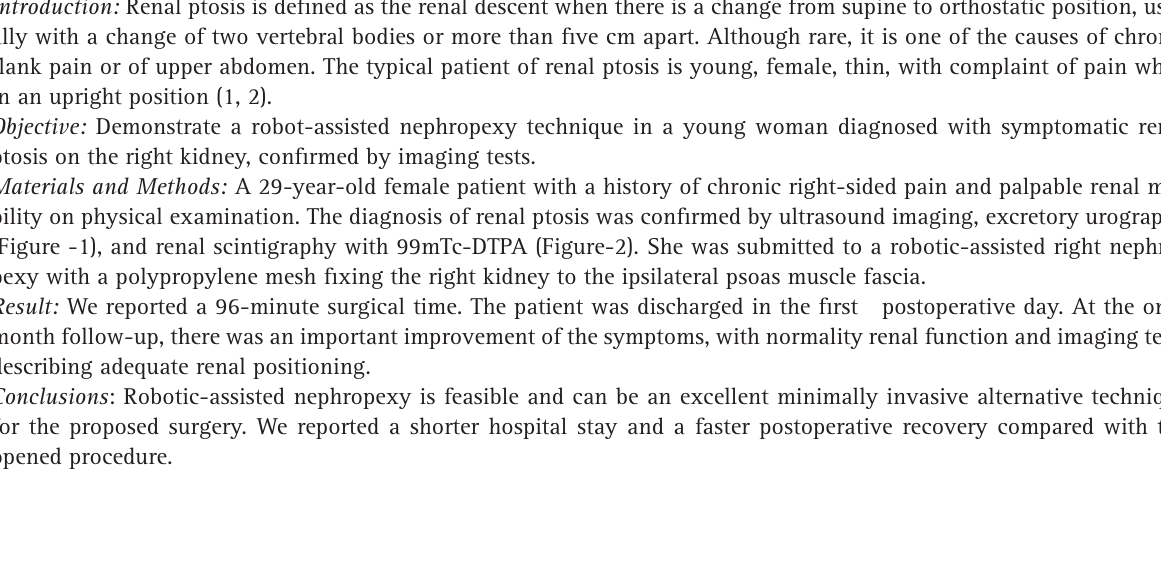
figure 1 - Excretory urography. figure 2 - Renal